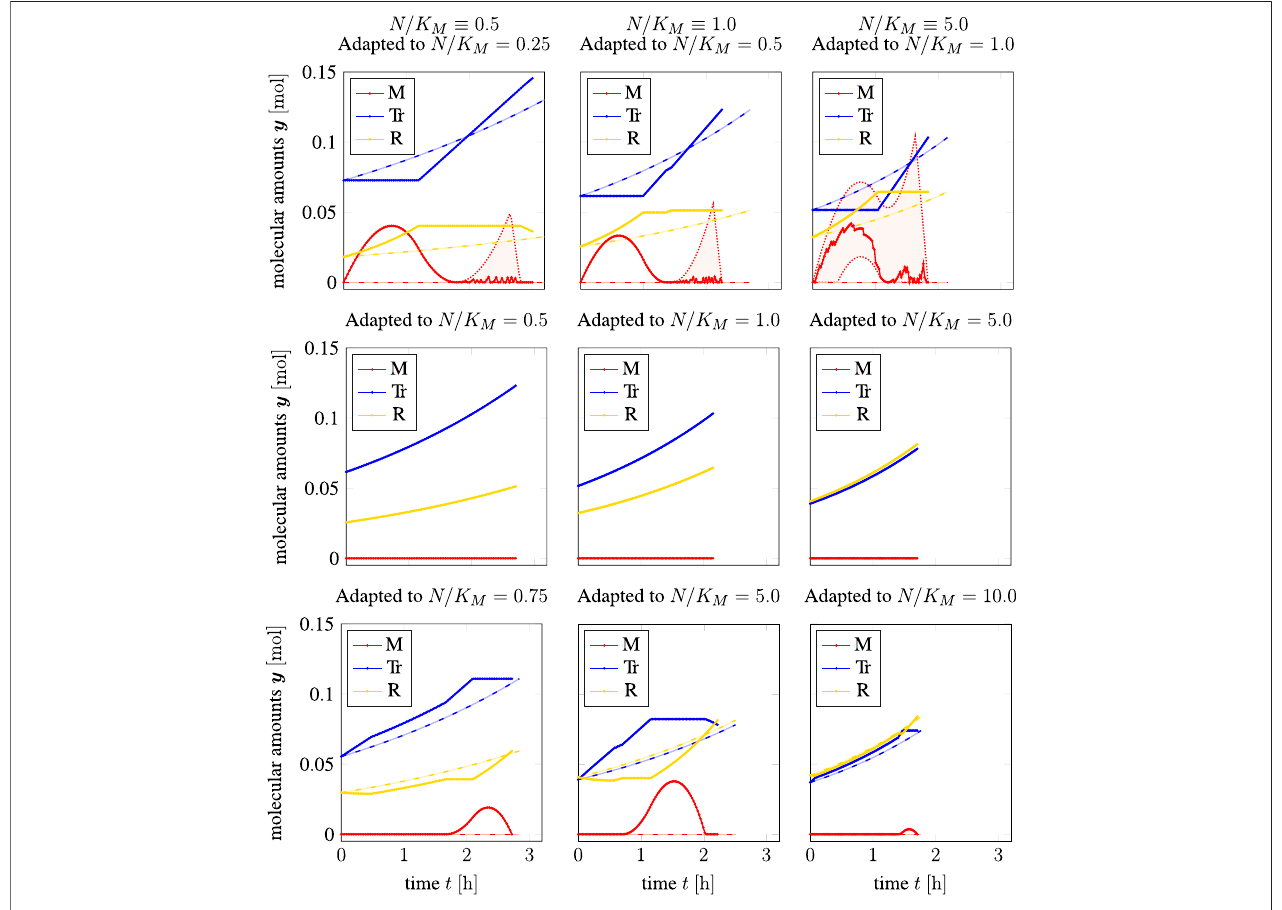
FIGURE4| Timecourse solutions oftime-optimal adaptationand acelldoublingexperiment under different constant external nutrientconditions; solid lines:TOA, shaded areas: TOA-VA, dashed lines: iterative RBA (simulated until cell doubling was achieved); upper row: pessimistically adapted, middle row: perfectly adapted (recoveryofiterative RBA), bottomrow: optimisticallyadapted forconstantrelative nutrient availability of N/K M =0.5(left column), N/K M =1.0(middlecolumn),and N/K M = 5.0 (right column).